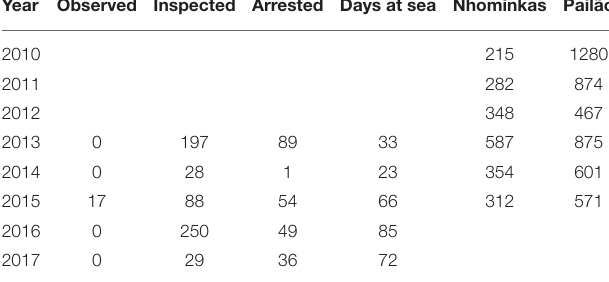
Source of vessel, and monitoring information: Government of Guinea Bissau (unpub. data).